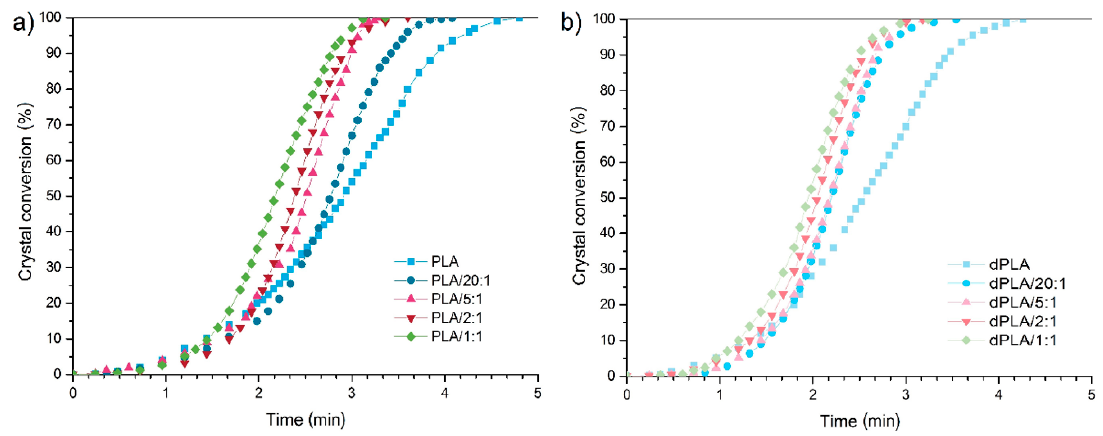
Figure 2. Crystal conversion curves of samples: ( a ) before biodegradation and ( b ) after biodegradation.